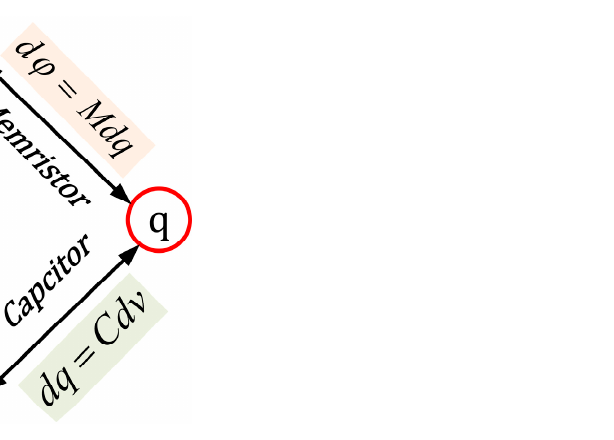
Figure 1. The relationship between the basic two-terminal elements (resistor, capacitor, inductor, and memristor).